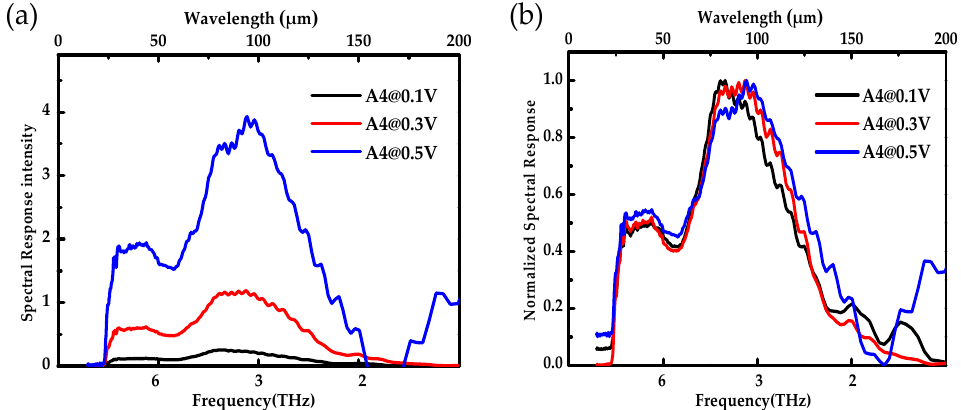
Figure 6. ( a ) The response spectra of the Ge:Ga THz photoconductive detectors. ( b ) The normalized response spectra of the Ge:Ga THz photoconductive detectors.